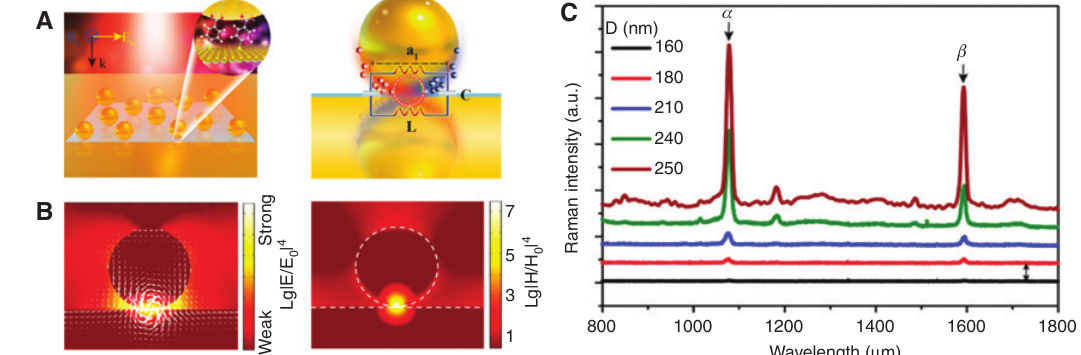
Figure 6: Magnetic resonance-enhanced Raman spectroscopy. (A) Schematic illustration of the investigated coupled metallic nanosphere-film system and LC model at the magnetic dipolar mode. (B) The electric (left) and magnetic (right) field distributions at the magnetic resonance frequency. (C) The Raman signal of an MBA monolayer of molecules adsorbed on the flat gold film in the nanogap region, acquired for different values of the nanosphere diameter D. The labels α and β refer to the characteristic Raman lines of MBA. Adapted with permission from Chen S, Zhang Y, Shih TM, et al. Plasmon-induced magnetic resonance enhanced Raman spectroscopy. Nano Lett 2018;18:2209–16 (Ref. [67]). Copyright 2018 American Chemical